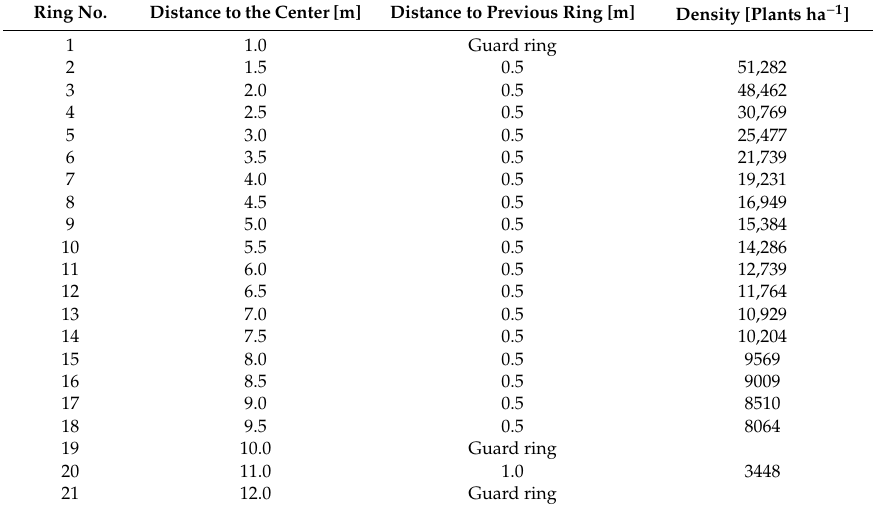
Table 1. Planting distances and tree